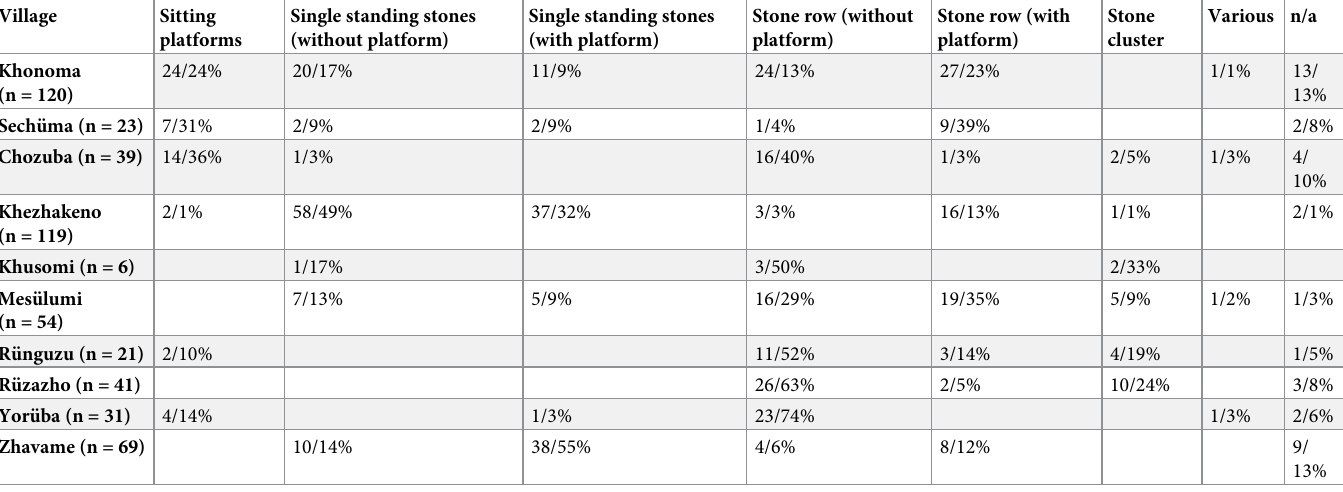
Table 1. The number and percentage of the different monument types in villages visited in 2016. Village Sitting Single standing stones platforms (without platform)